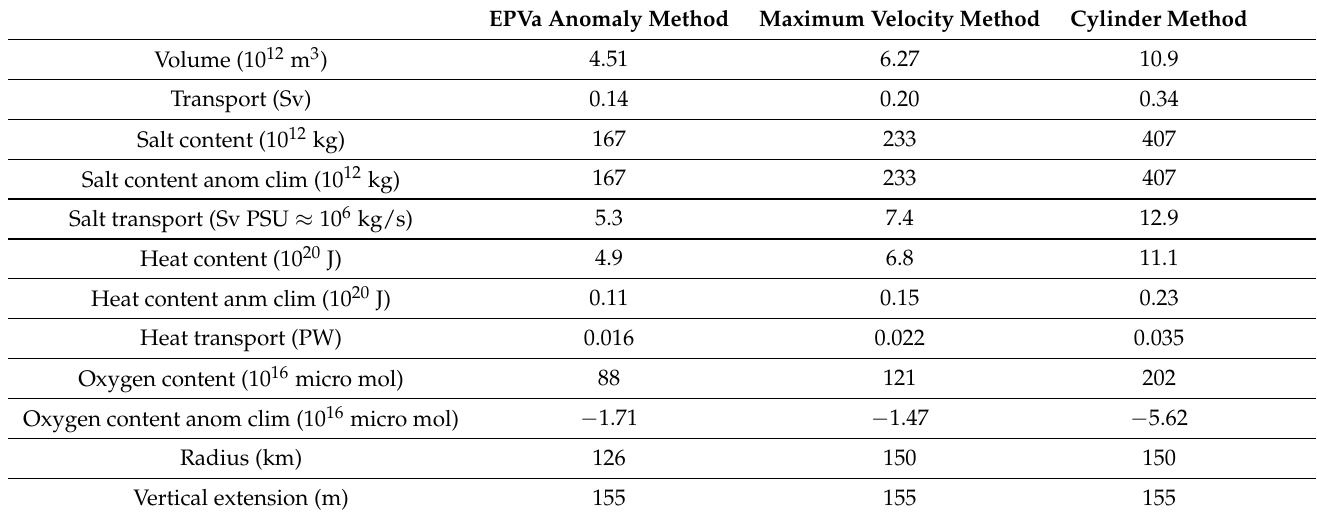
Table 1. A2 volume, heat, salt and oxygen content, content anomalies and transports for Section 5 of R/V L’Atalante, using 3 different